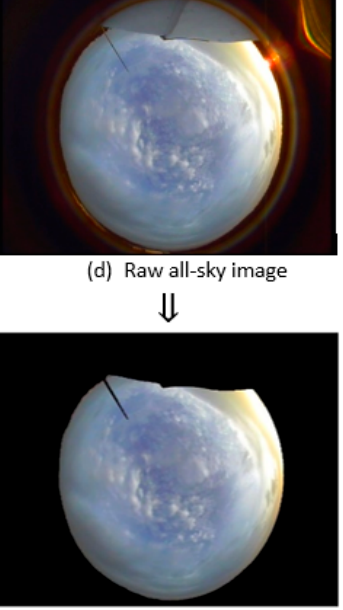
Figure 4. The figure shows the masking process. The mastermask ( c ) is produced by combining the Non-ROI ( a ) with the Horizon masker ( b ). The mastermask is then applied to the raw all-sky image ( d ) to obtain the clean all-sky image ( e